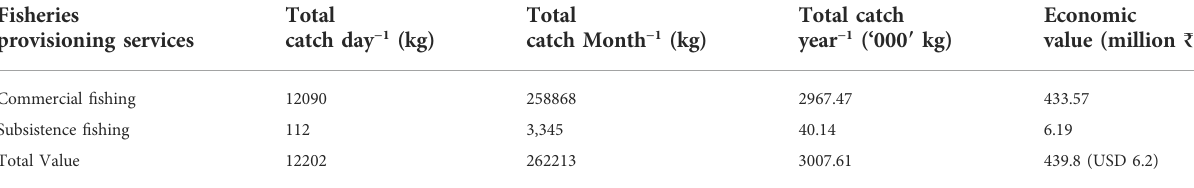
TABLE 2 The total value of fi sh caught from sampled fi shing sites in the Cauvery River.